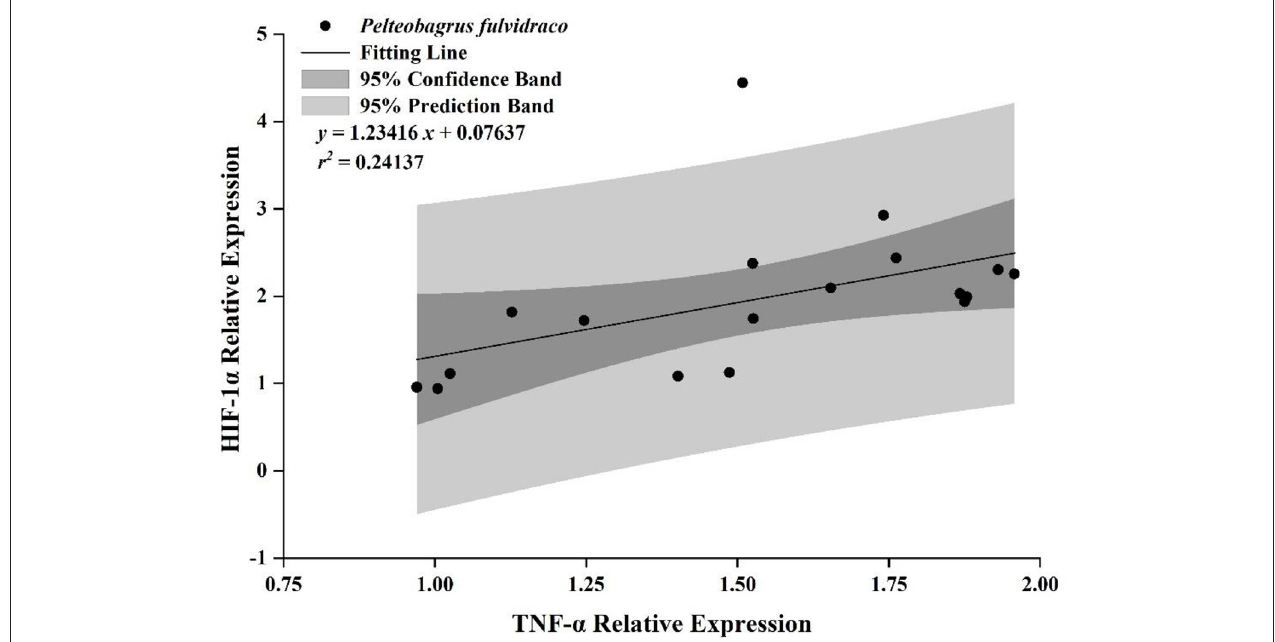
FIGURE 6 | The correlation between the relative expression of HIF-1 α and TNF of P. fulvidraco by unary linear